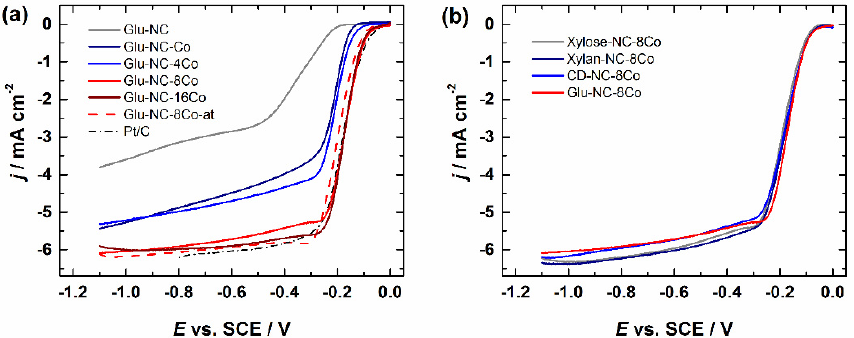
Figure 4. RDE voltammetry curves of O 2 reduction in O 2 -saturated 0.1 M KOH on ( a ) glucose-derived catalyst materials and Pt/C; ( b ) catalysts derived from various saccharides. ω = 1900 rpm, ν = 10 mV s − 1 . Table 1. ORR parameters of the electrocatalysts in 0.1 M KOH solution.